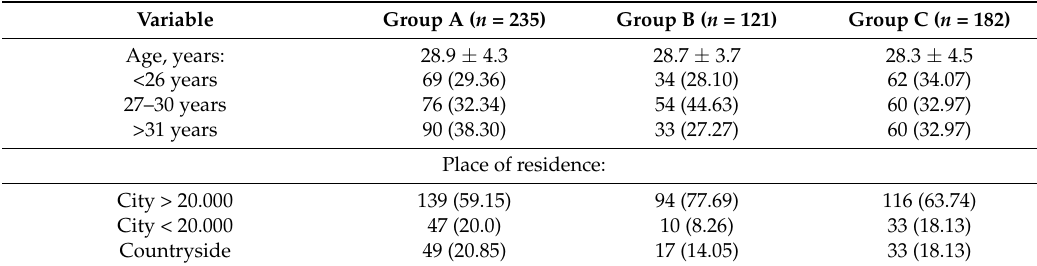
Table 1. Selected features of sociodemographic characteristic of studied